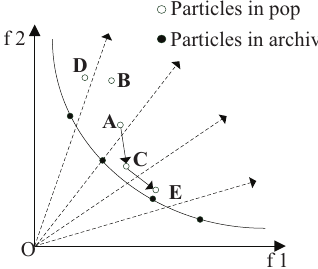
Figure 6. Diagram of particle update by traditional particle swarm optimization